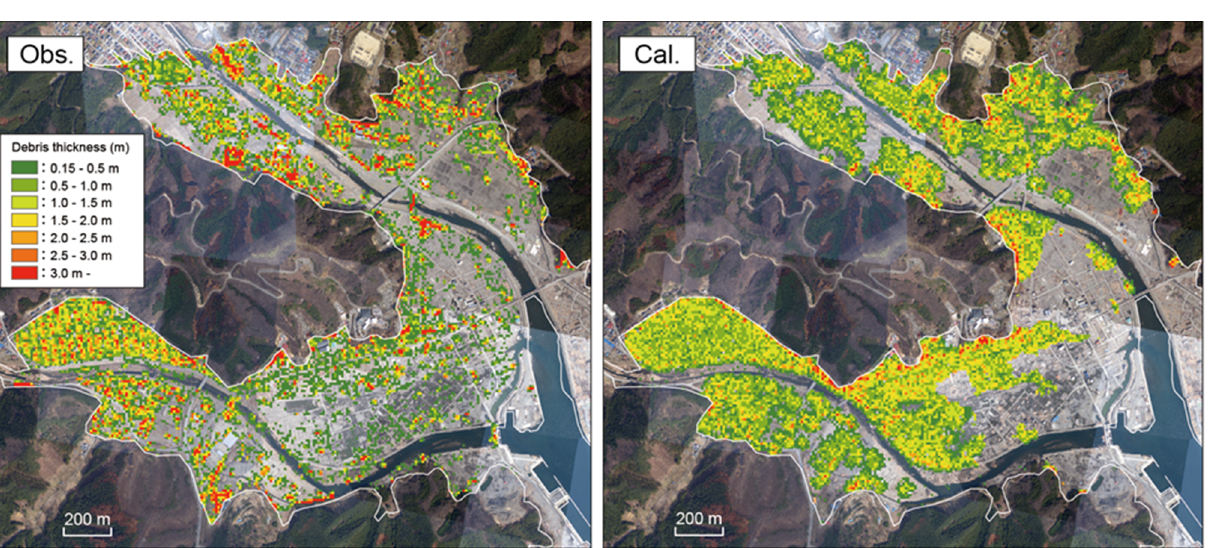
Figure 8. Observed and calculated NDT in relation to L *.